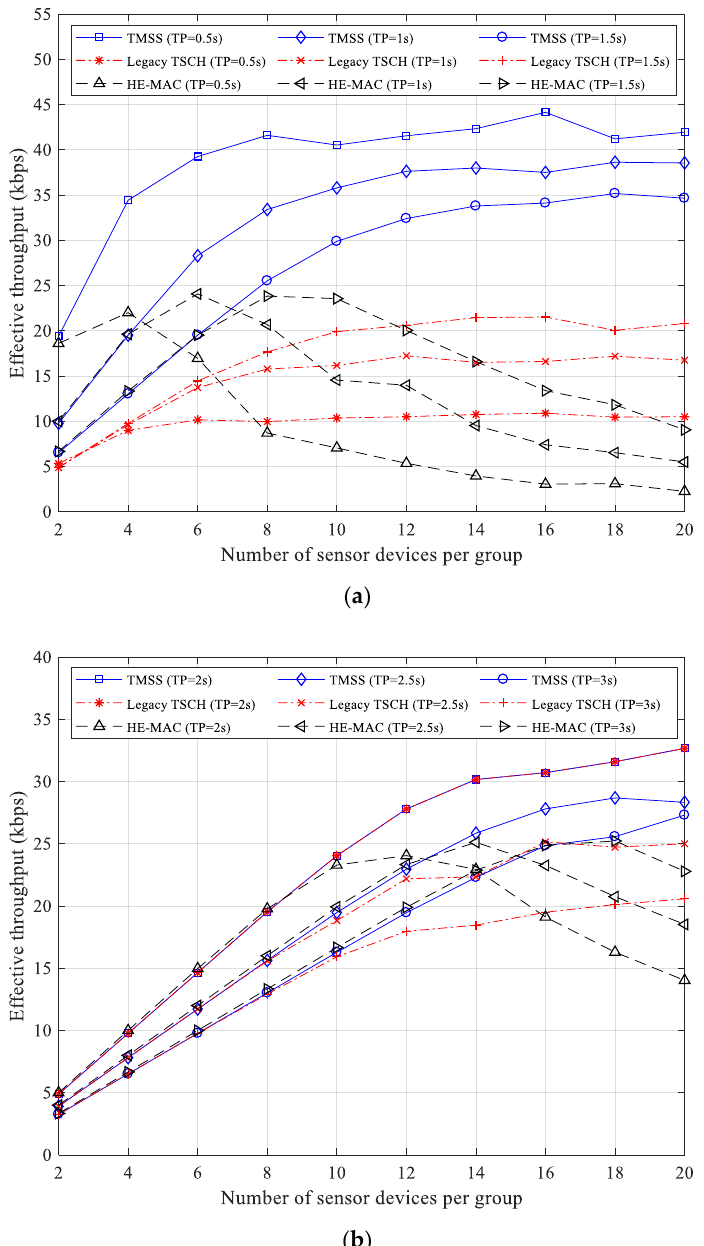
Figure 7. Effective throughput: ( a ) short TP scenario; ( b ) long TP scenario. Figure 8a,b show the energy utilization for short and long TP scenarios, respectively.